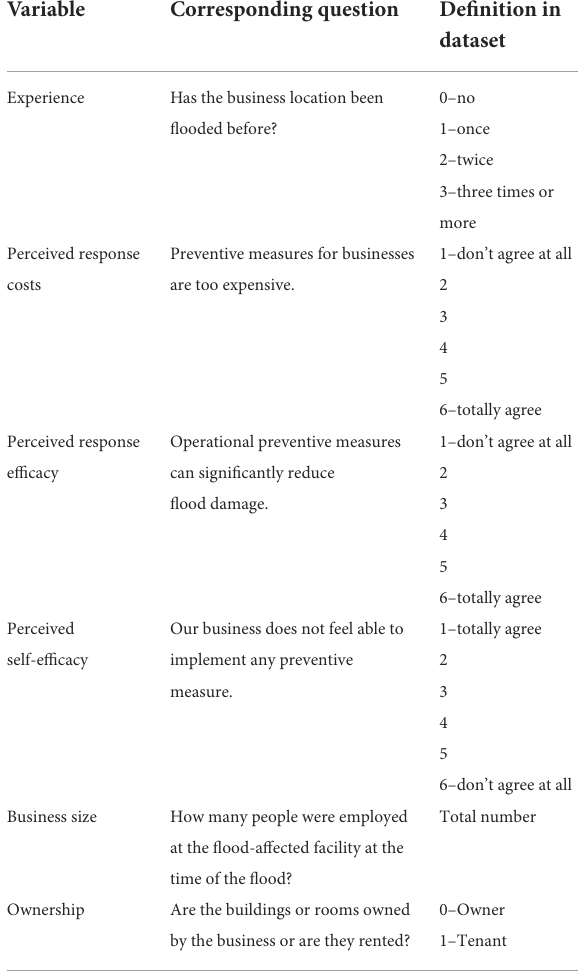
TABLE 3 Overview of the analyzed